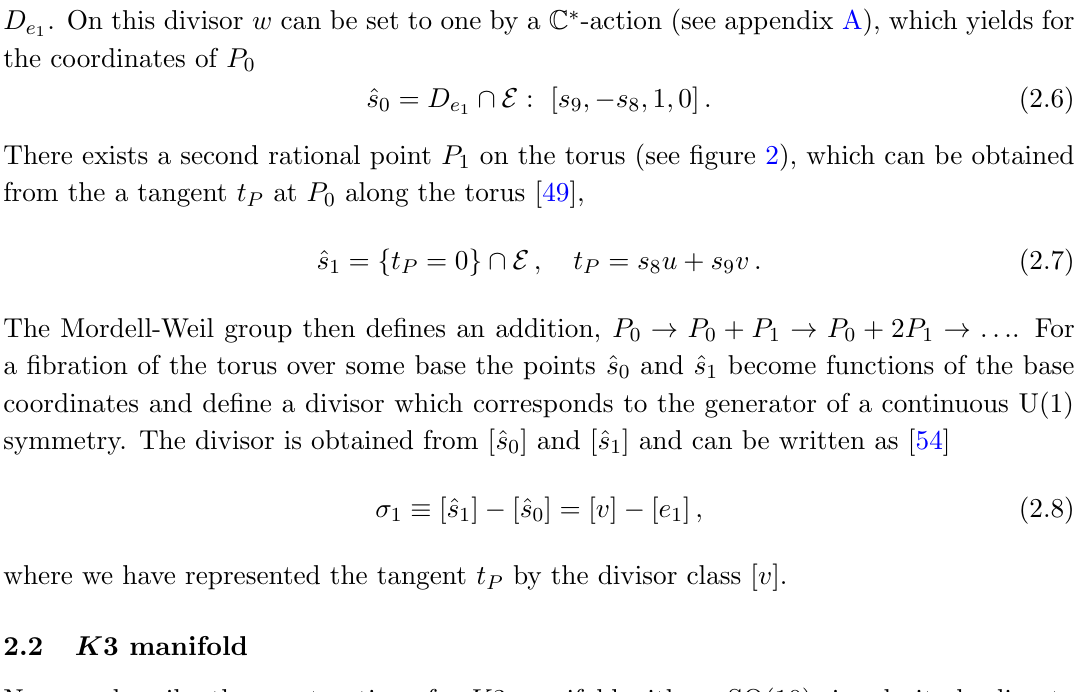
with two points, ^ s 0 and ^ s 1 (see E